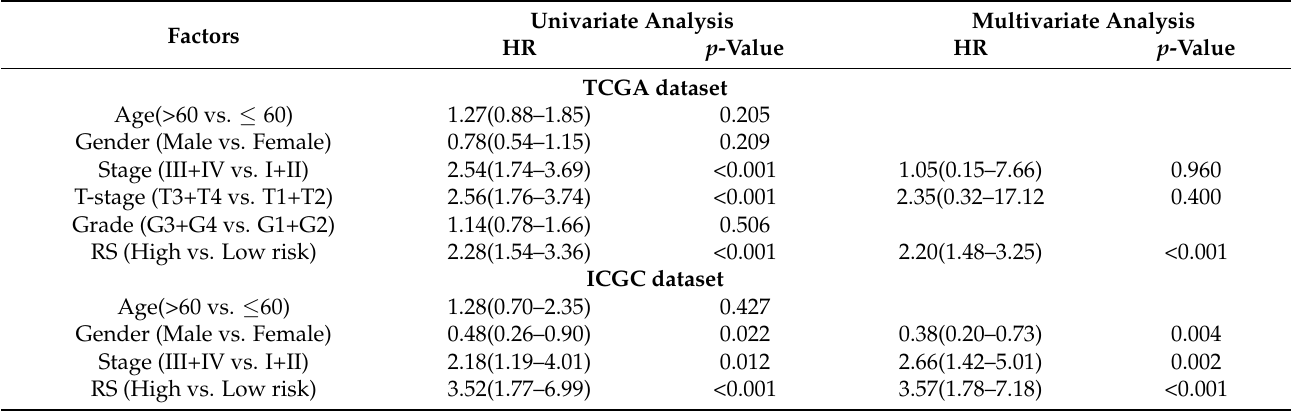
Figure 5. Prognostic and diagnostic assessment of four-gene signature for HCC. Four-gene signature diagnostic performance in classifying HCC and normal tissue in TCGA dataset ( a ). Validation of four-gene signature expression between HCC and normal tissue using external International Cancer Genome Consortium (ICGC) dataset ( b ). Kaplan–Meier (KM) survival analysis for high-risk and low-risk subgroups stratified RS model in ICGC dataset ( c ). Validation of four-gene signature by time-dependent ROC analysis in ICGC dataset ( d ). RS, risk score. Table 3. Univariate and multivariate Cox analyses of clinical pathological factors and risk model in TCGA and ICGC HCC